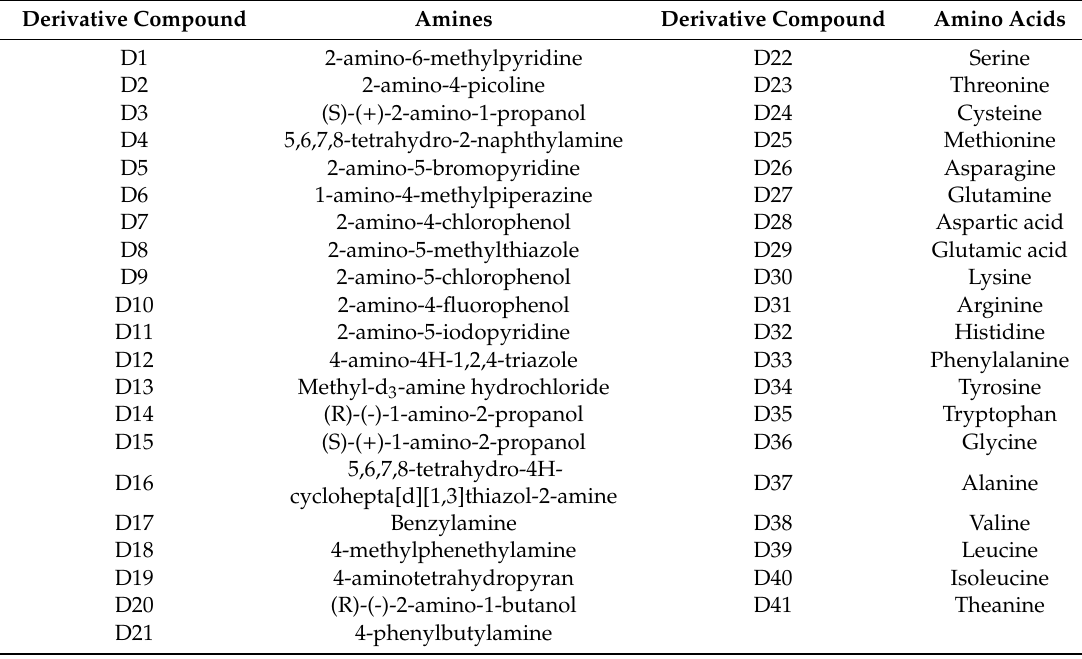
Table 1. Amines and amino acids used for synthesis of Monascus pigment derivatives. Derivative Compound